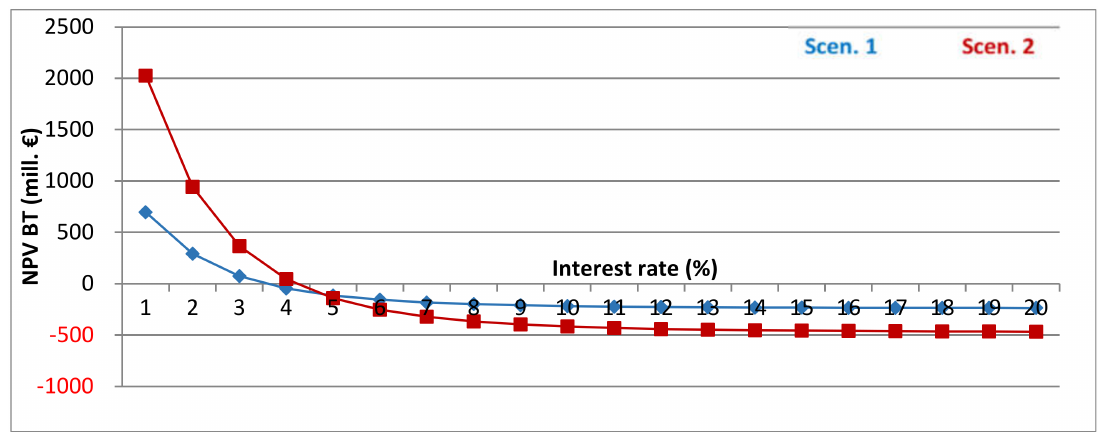
Figure 12. Net present value before tax as a function of the interest rate, Scen. 1 and 2, incl. flooding